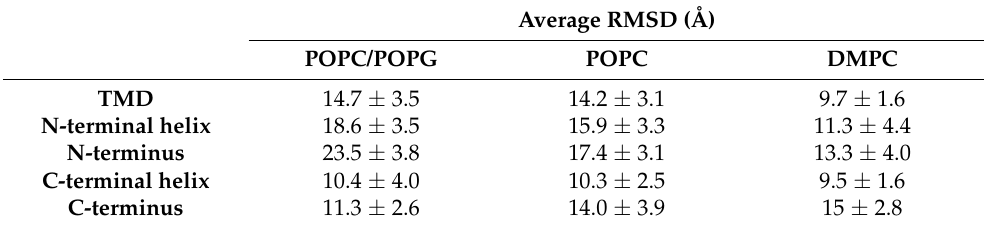
Table 1. AverageRMSDcalculatedfromtheRMSDsshowninFigure3. Theerrorrepresentsstandard